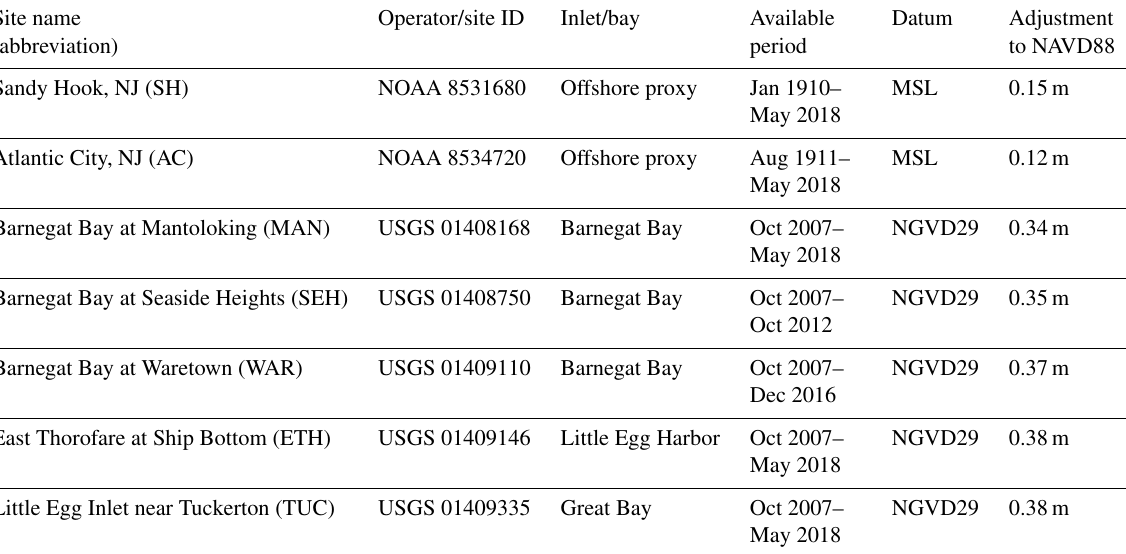
Table 1. Sites used in water level analysis. Check Fig. 1 for locations. Information on instrumentation type, sampling, and quality control methodologies for the USGS stations is available from https://waterdata.usgs.gov/nwis/inventory (last access: 15 August 2019). National Oceanic and Atmospheric Administration (NOAA); U.S. Geological Survey (USGS). MSL: mean sea level; NGVD29: National Geodetic Vertical Datum of 1929; NADV88: North American Vertical Datum of